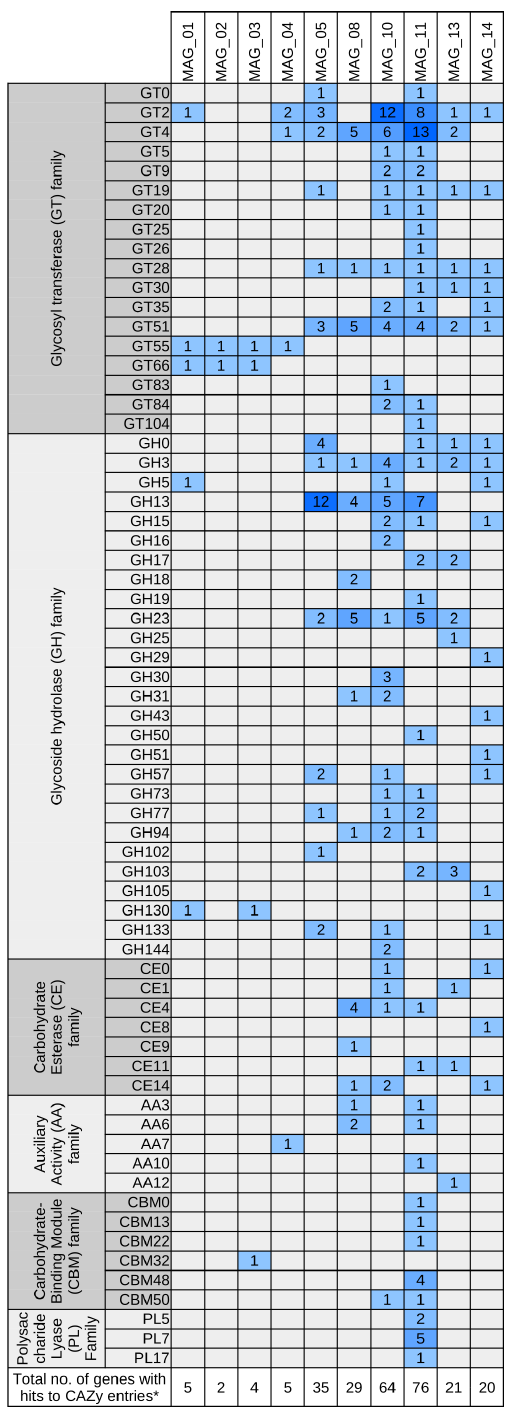
Figure 5. Carbohydrate-active enzyme (CAZy) families identified in the ten high quality metagenomically assembled genomes (MAGs) as deciphered by means of dbCAN2 in silico screening (dbCAN2—web server for automated Carbohydrate-active enzyme ANnotation). Columns represent the MAGs; rows are blocked by CAZy modules and further partitioned into families of structurally-related catalytic and carbohydrate-binding modules (or functional domains) of enzymes that degrade, modify, or create glycosidic bonds (http://www.cazy.org/). Colors of the heatmap indicate the number of genes assigned to the respective CAZy